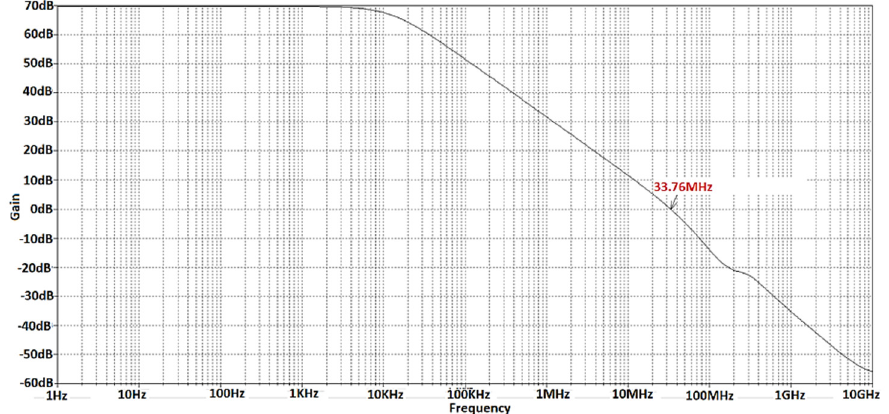
Figure 3. Open loop gain of proposed operational amplifier having a unity gain frequency of 33.76 MHz.